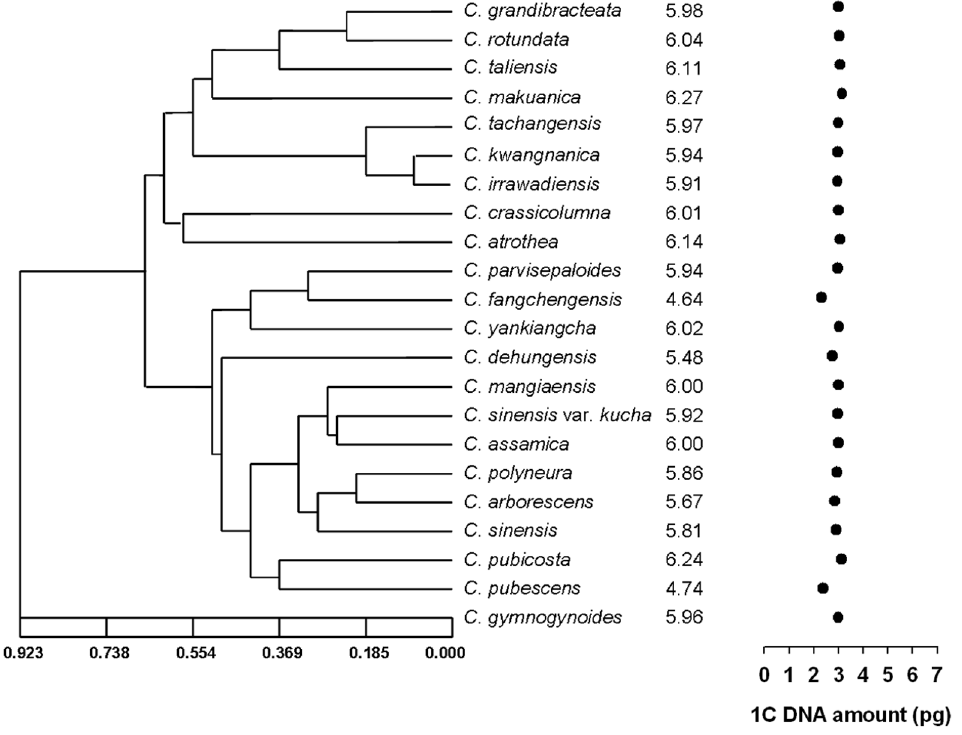
Figure 3. Nuclear DNA contents and evolutionary relationships among members of the section Thea [ 31 ] . The phylogenetic tree of the section Thea was constructed by using UPGMA and Nei and Li’s similarity coefficient from pairwise comparisons between the 22 species and varieties N based on RAPD markers [44]. The estimated 2C-values for each species are shown on the right of species, while the 1C DNA amount (pg) which also equals the genome size is shown by